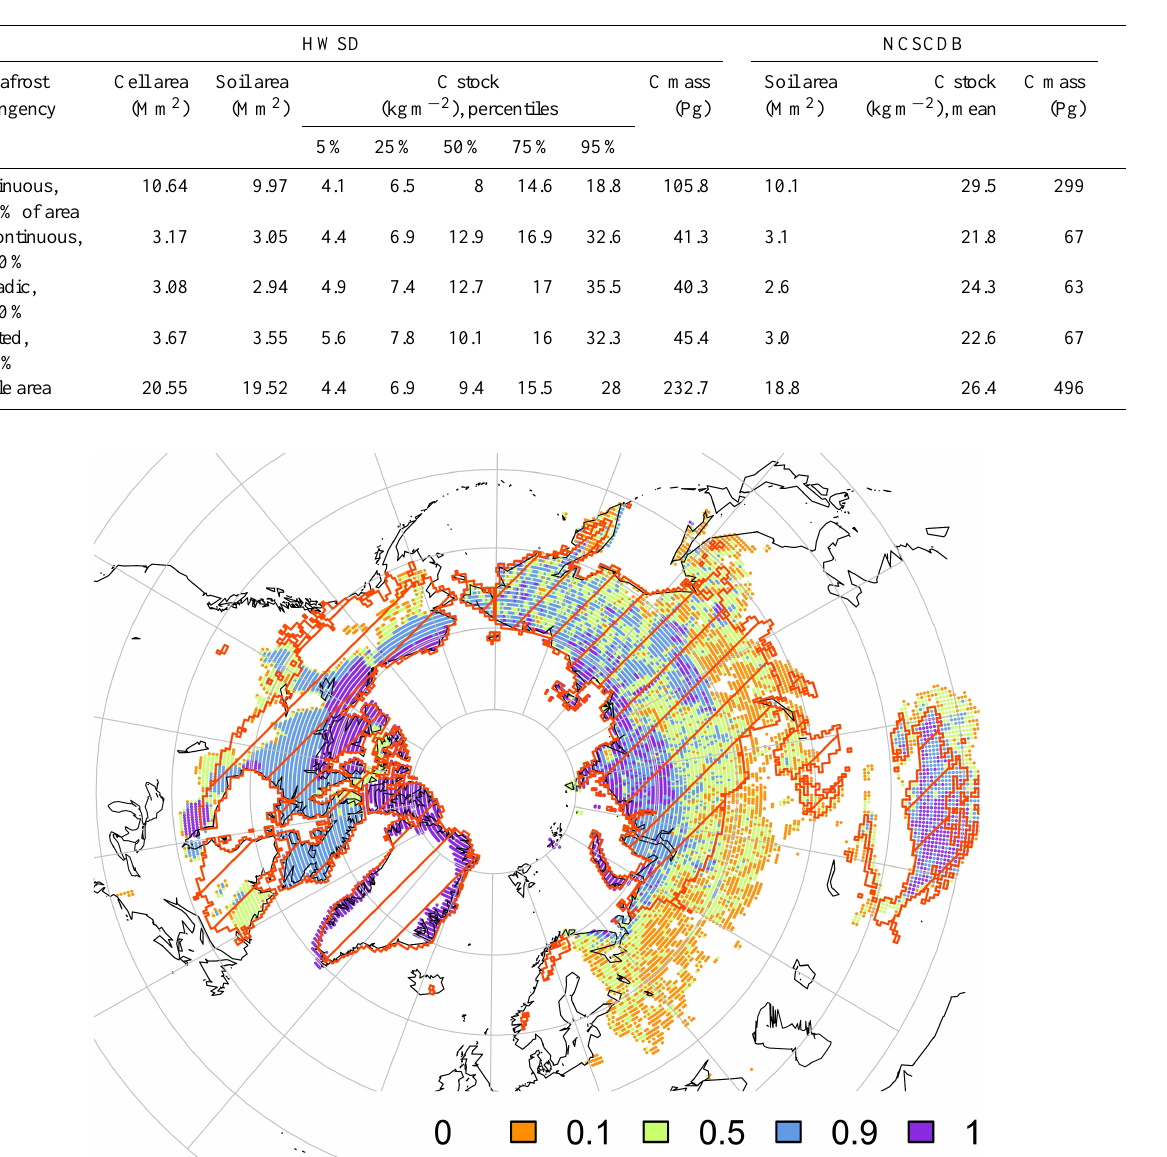
Table 5. Comparison of organic carbon stocks (top 1m) between HWSD v.1.1-adjusted and the NCSCDB (Tarnocai et al., 2009). Permafrost contingency refers to the Circum-Arctic Map of Permafrost and Ground-Ice Conditions. NCSCDB used different soil areas within grid cells than the HWSD. Percentiles refer to the distribution of C stocks in each grid cell within the soil area mentioned. 1Mm 2 = 10 6 km 2 .